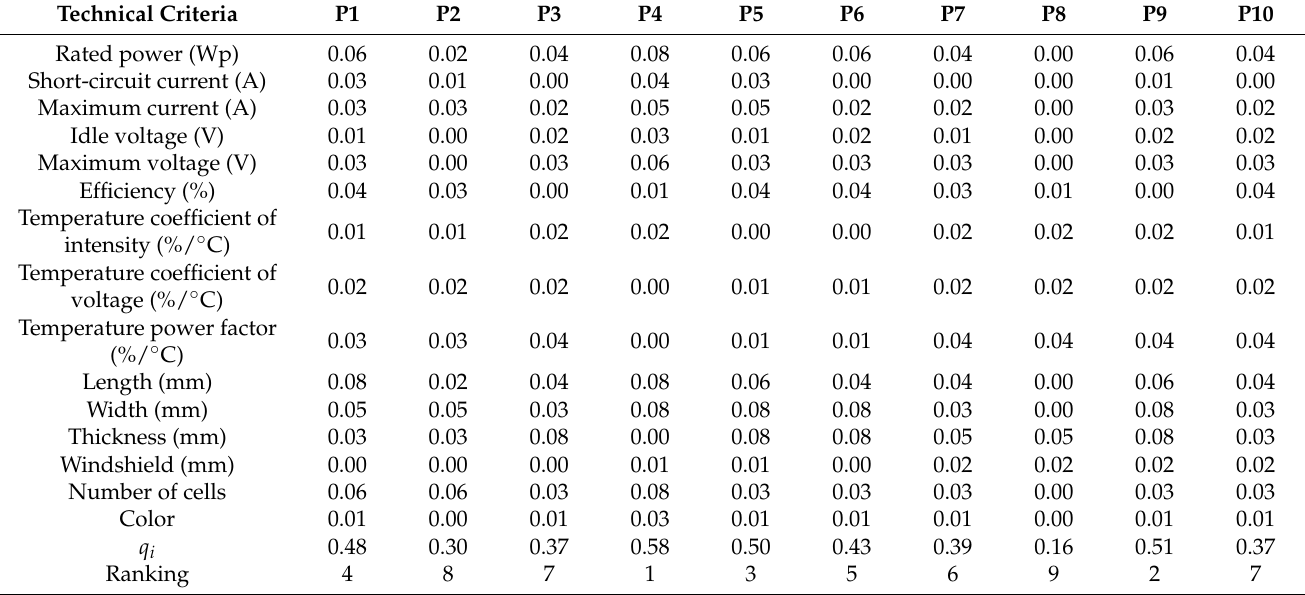
Table 9. Quality of photovoltaic